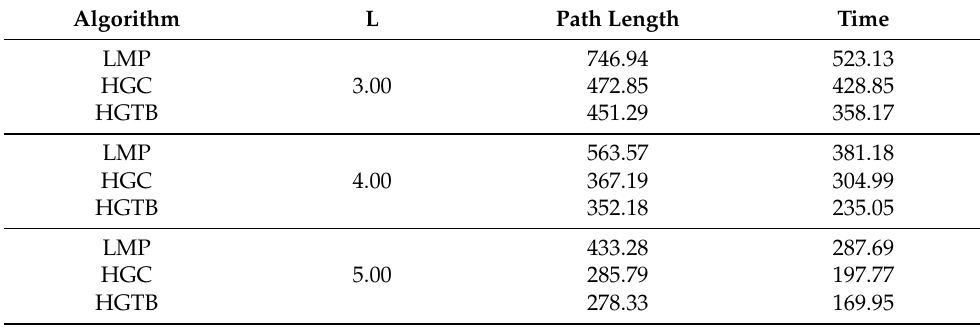
Table 3. Algorithm budgets for different coverage densities in study area